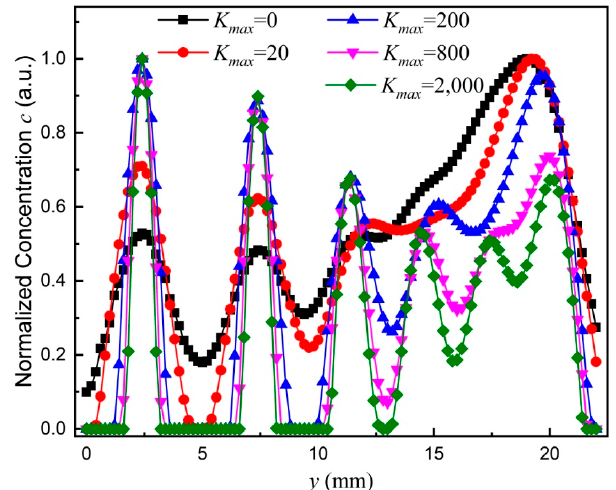
Figure 5. Normalized concentration versus y for K max values. Symbols represent experimental results whereas solid lines are guides to the eye.